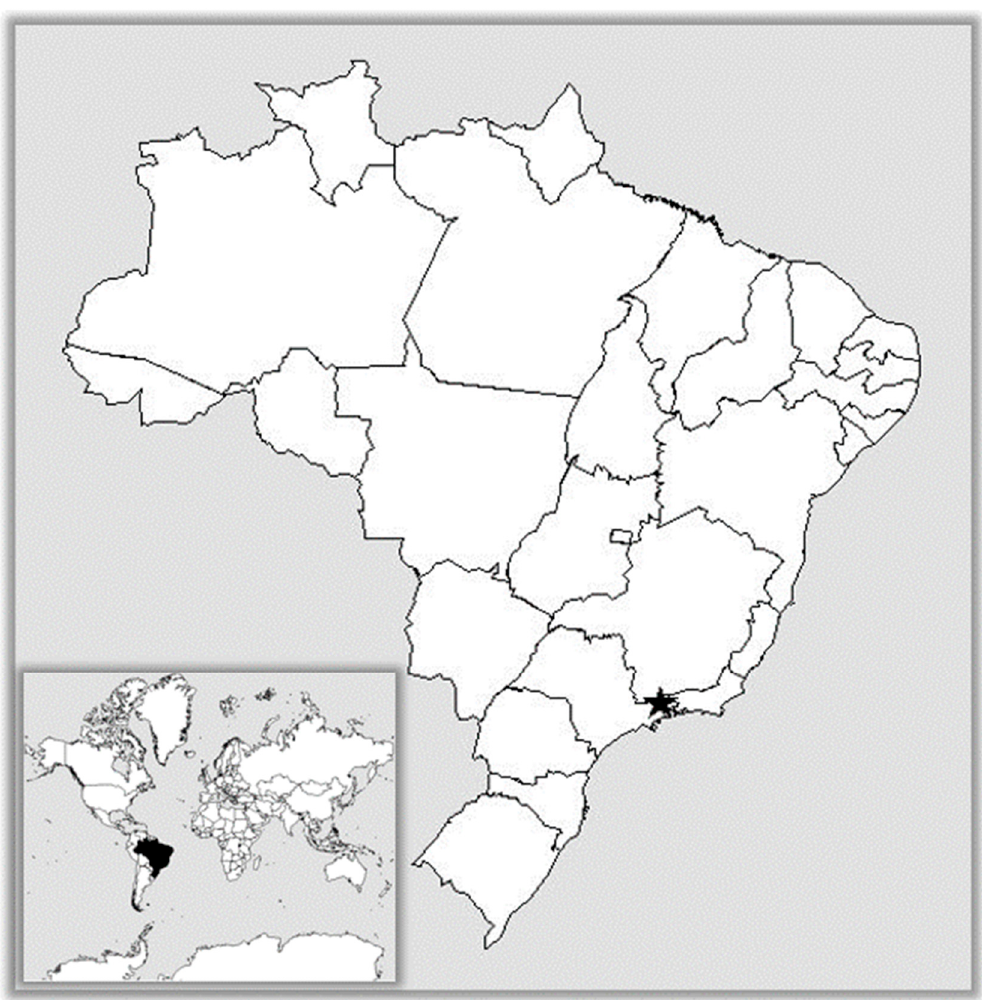
Figure 1. General location of Suzano’s Americana Farm in Guaratingutá, São Paulo, Brazil [50,51]